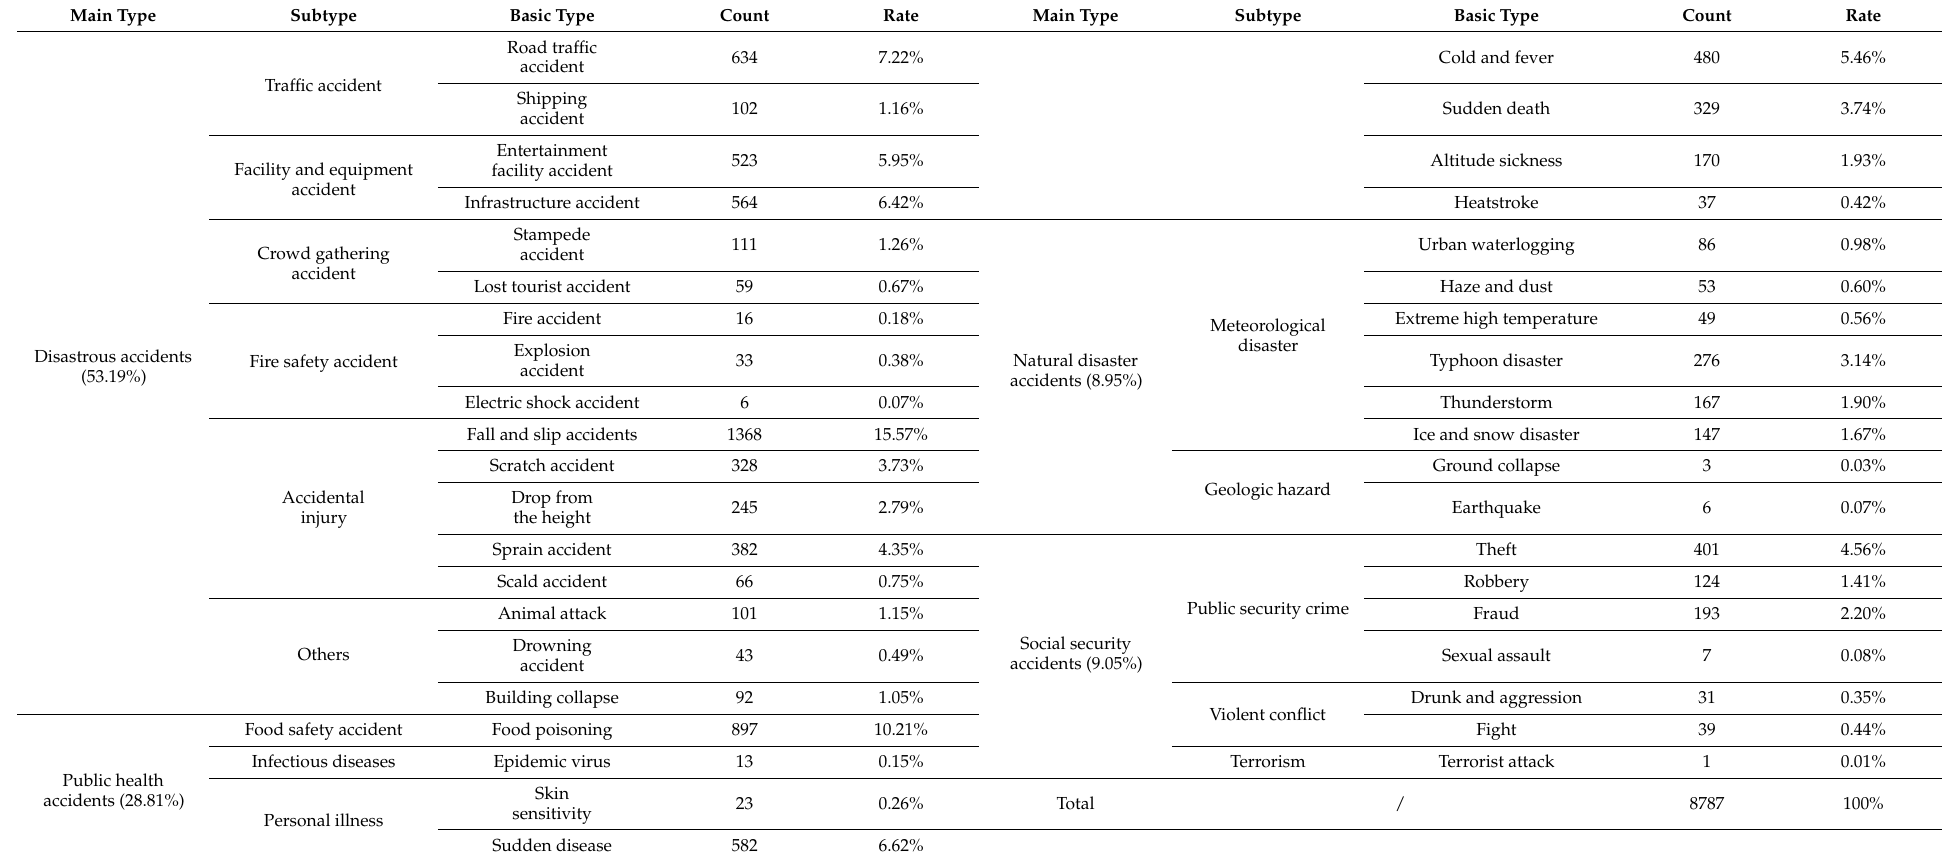
Table 1. Types of night tourism safety accidents in